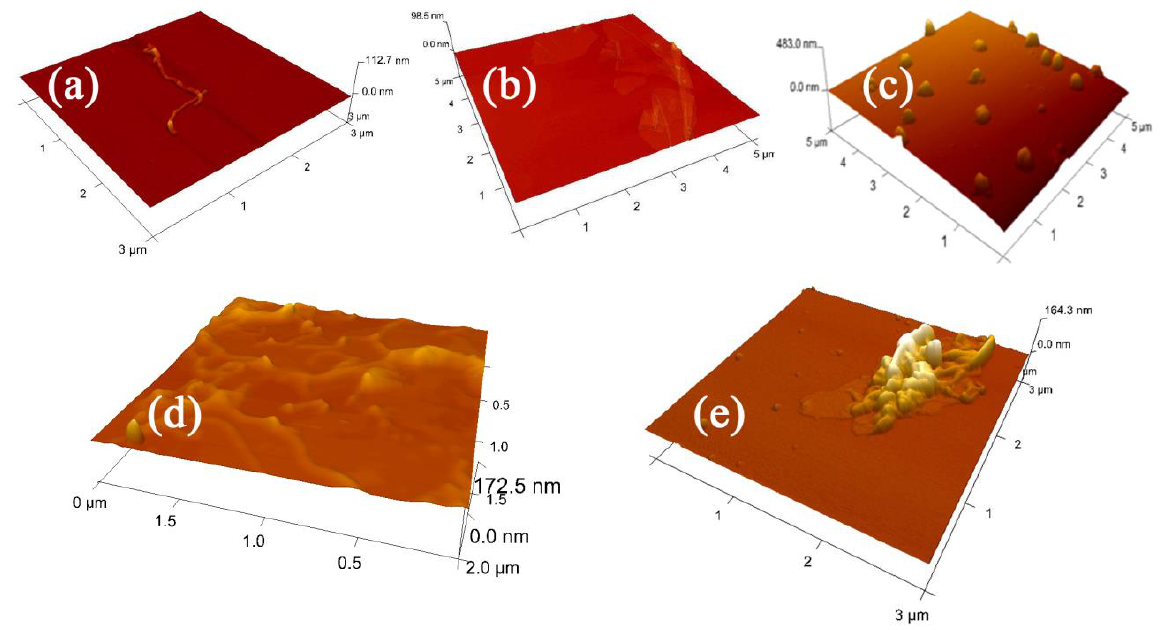
Figure 2. Atomic force microscopy (AFM) images of ( a ) CNT (NC 7000), ( b ) GO, ( c ) Buckminster fullerene (C 60 ), ( d ) C 60 -g-CNT and ( e ) C 60 -g-rGO.